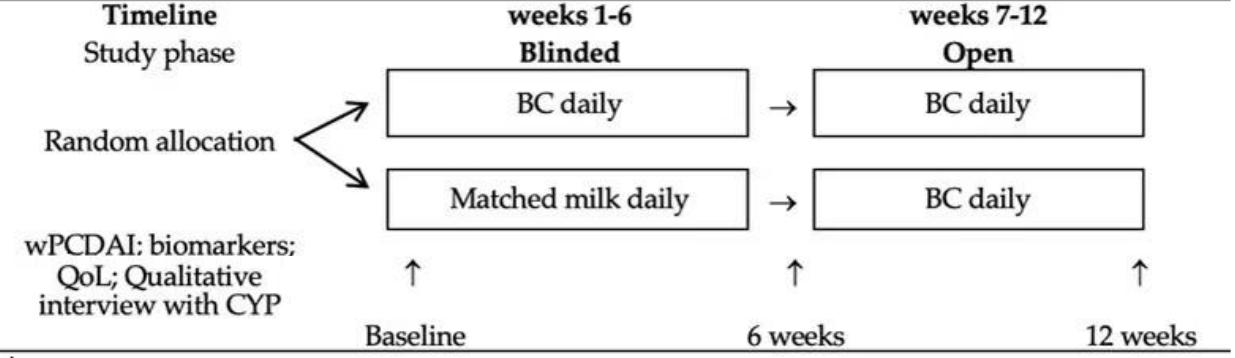
Figure 1. Trial design. BC = bovine colostrum; wPCDAI = weighted paediatric Crohn’s disease activity index; QoL=quality of life; CYP=children and young people.